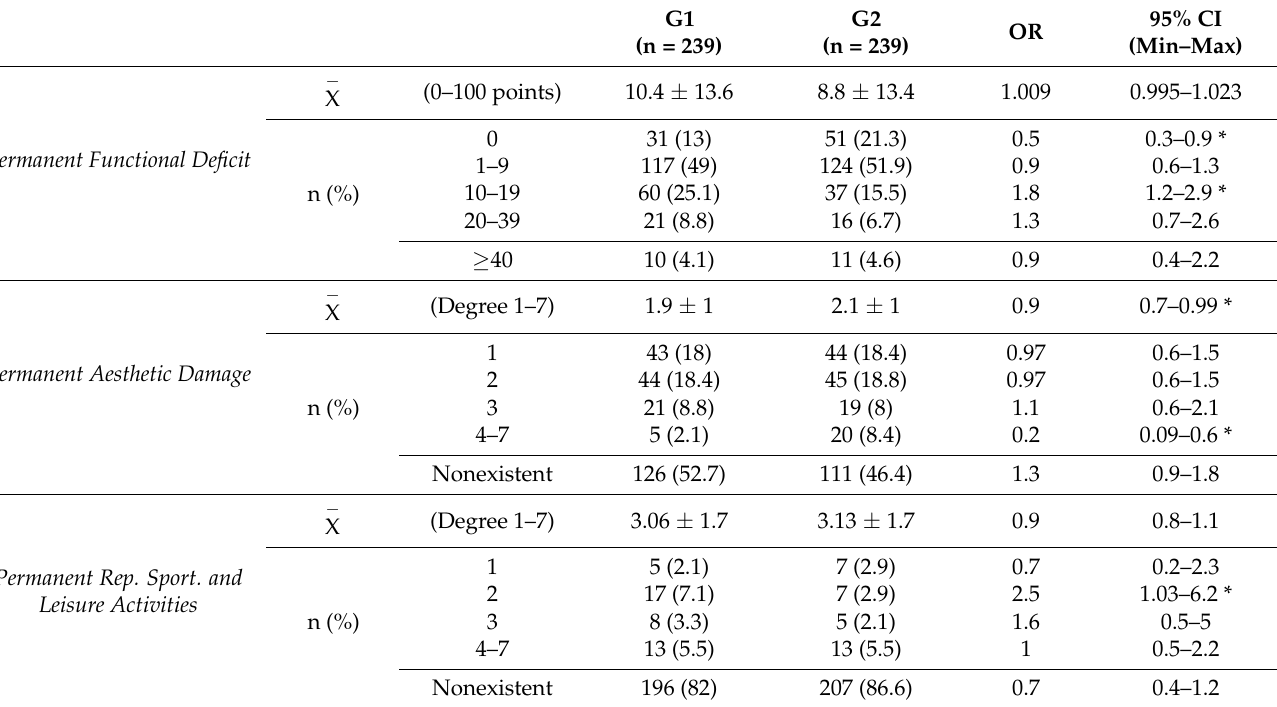
Table 5. Permanent medico-legal damage parameters